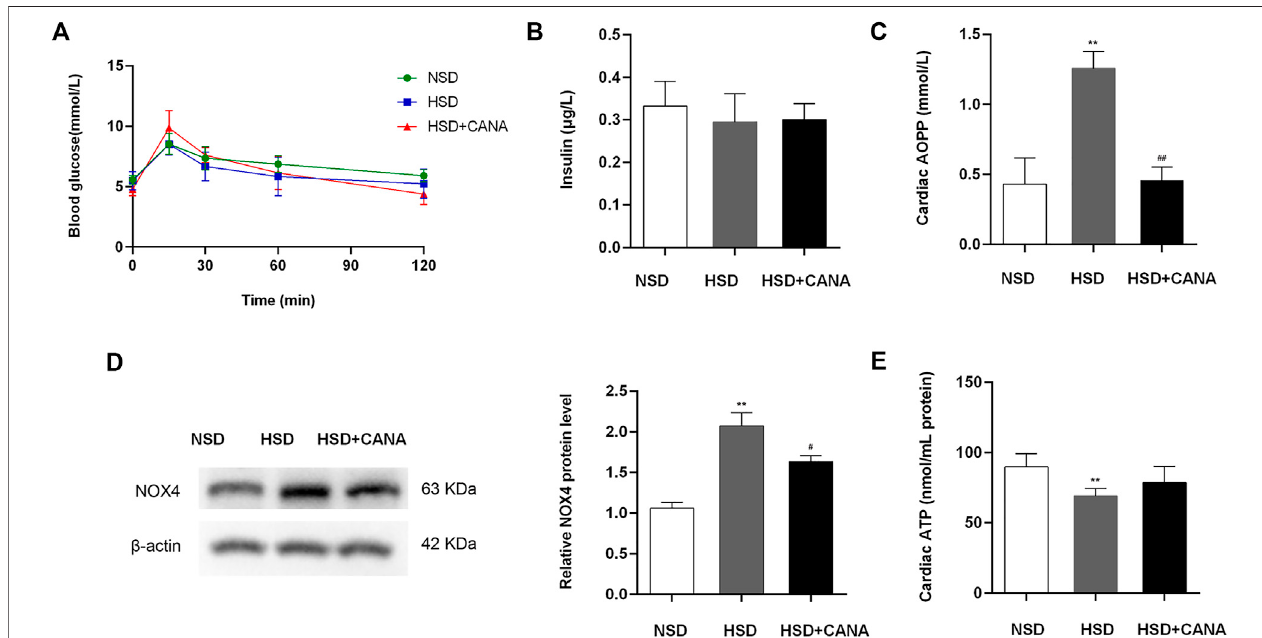
FIGURE 4 | Effects of CANA on blood glucose, oxidative stress, and cardiac ATP production. (A) Oral glucose tolerance (2 mg/kg) after overnight fasting for 12 h; (B) Serum insulin after overnight fasting for 12 h; (C) Cardiac advanced oxidation protein products to assess oxidative stress; (D) Measurement of NOX4 protein levels; (E) Cardiac ATP production was determined in indicated groups. NSD, normal-salt diet; HSD, high-salt diet. ** p < 0.01 vs. NSD. # p < 0.05, ## p < 0.01 vs. HSD.